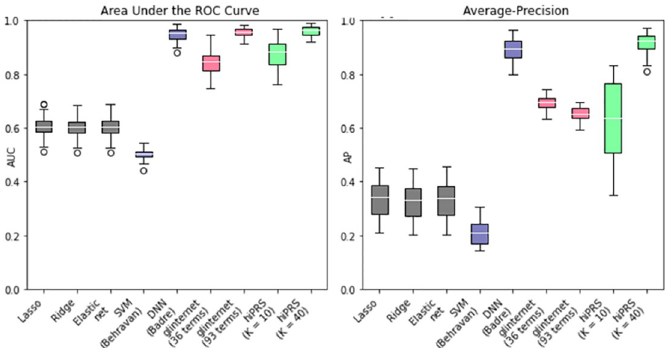
Fig 4. hi PRS results on risk prediction against benchmark PRSs and ML approaches. AUC (left) and AP (right) performance distributions of 30 independent trials. In grey the three traditional penalized PRSs approaches with additive effects only; in violet the two ML algorithms (SVM-Behravan and DNN-Badre); in pink glinternet algorithm for two model dimensions (3 interactions, i.e. 36 terms, and 8 interactions, i.e. 93 terms); in green hi PRS for K = 10 and K =